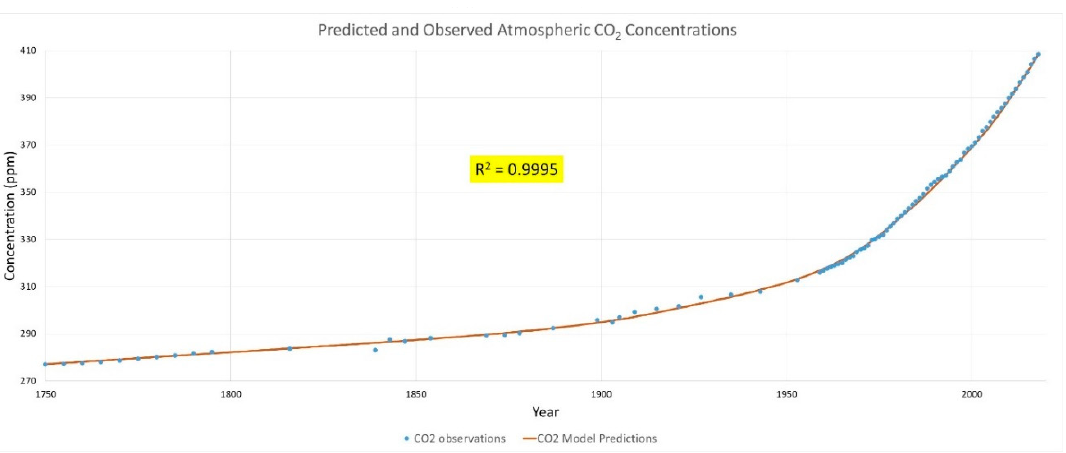
Figure 8. Measured and predicted CO 2 concentrations based on a 2018 datum base year. Curve is best fit to data using Equation (2) with scaling factor α 3 = 51.3% (AF FF ).